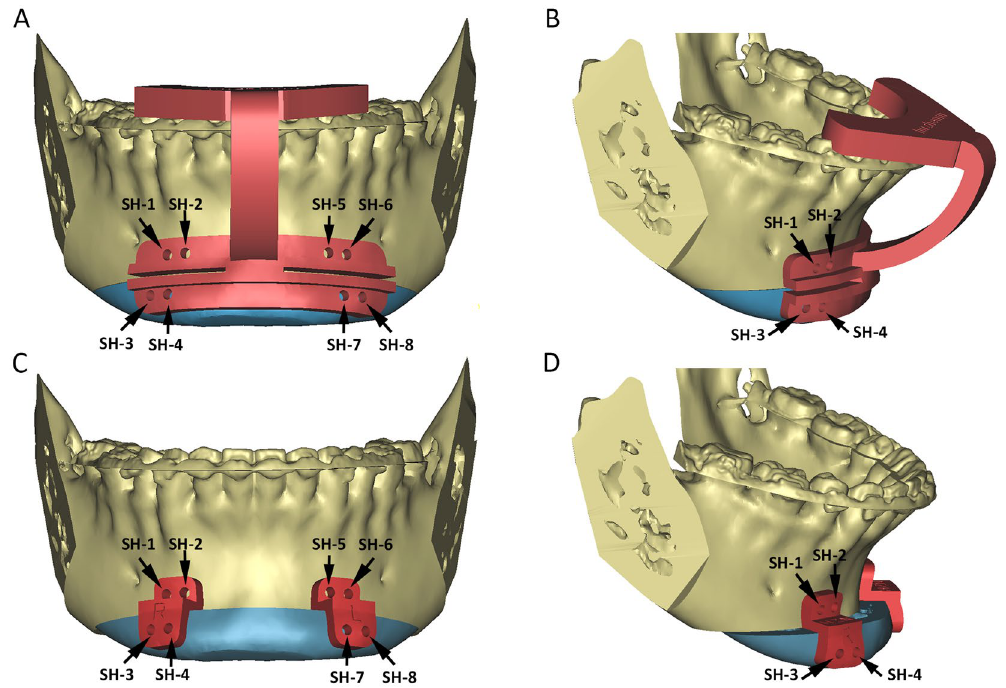
Figure 1. ( A , B ) The upper portion of the cutting guide is designed like a dental splint. The lower portion of the guide is designed to indicate the cutting lines and the trajectory of the cutting plane. Eight screw-hole drilling guides (black arrows) are designed on both sides of the osteotomy cutting lines to provide stable bony reference landmarks. ( C ) After the osteotomy is completed, a pair of the repositioning guides are installed. The upper portion of each guide is attached to the distal mandible using the original two screw holes (SH-1 and SH-2 on the right side; SH-5 and SH-6 on the left side). The lower portion of each guide includes two repositioning screw holes in their planned final positions (SH-3 and SH-4 on the right side; SH-7 and SH-8 on the left side). ( D ) The new location of the screw holes on the repositioning guide will automatically bring the chin segment into its planned final position as the screws are placed into the appropriate screw holes. (Chin segments are marked in teal; SH: screw